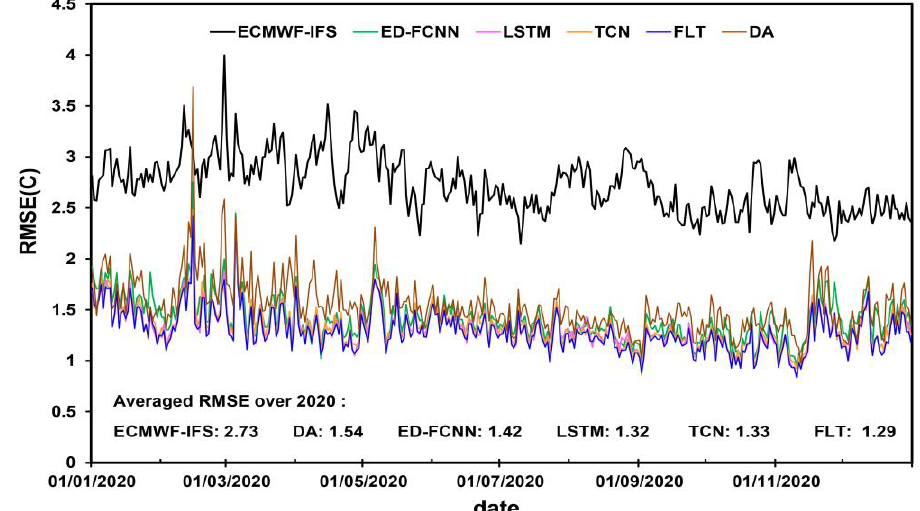
Figure 7. The average RMSE at all stations over the Chinese mainland on each calendar day during the validation period using five post-processing models and the ECMWF-IFS model (the average RMSE of each model is also shown in the top; unit: °C).